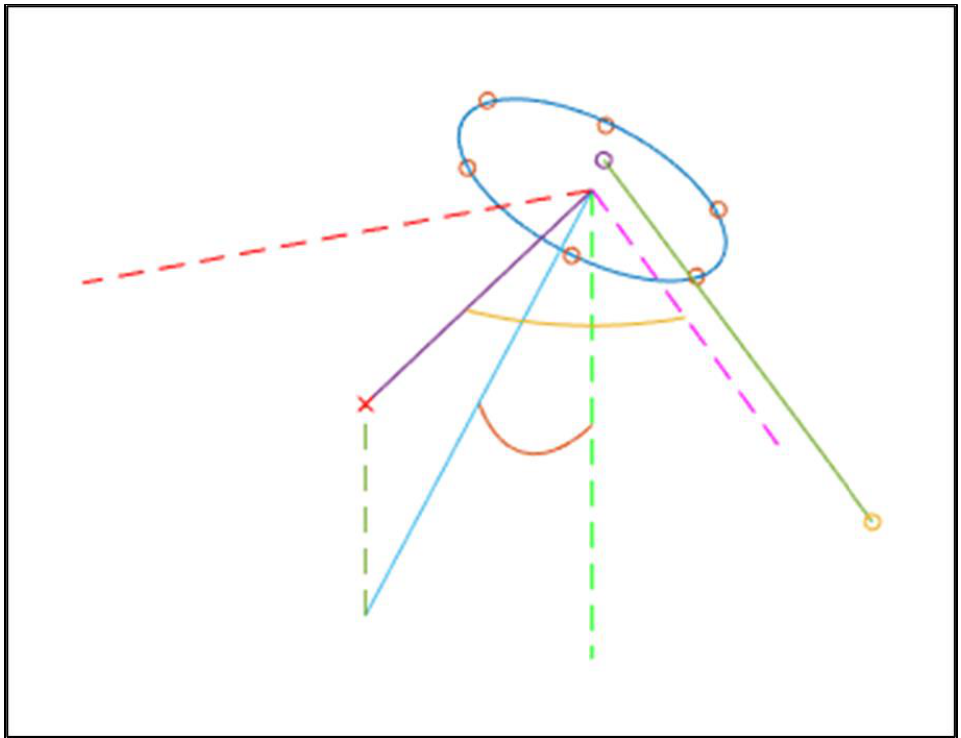
Figure 2. Representation of the 3D data collected using the CMM. The dashed lines represent the anatomic coordinate frame with the anterior axis (red) perpendicular to the plane of the X-ray, the lateral axis (pink) parallel to the inter-teardrop line (full green line connecting the yellow and purple points), and the inferior axis (green) mutually perpendicular to the other two axes. The red circles represent the points collected along the acetabular rim, and the blue ellipse describes the contour of the acetabular rim, calculated using a best fit circle in 3D. The light blue line represents the normal axis to the plane of the acetabular rim, and the red arc between the inferior axis (dashed green line) and the light blue line is the anatomic inclination angle described by Murray et al. The full purple line is the projection of the normal axis onto the transverse plane (plane described by the red dashed line and the pink dashed line). The yellow arc between the lateral axis (dashed pink line) and the purple line is the anatomic anteversion angle described by Murray et al.